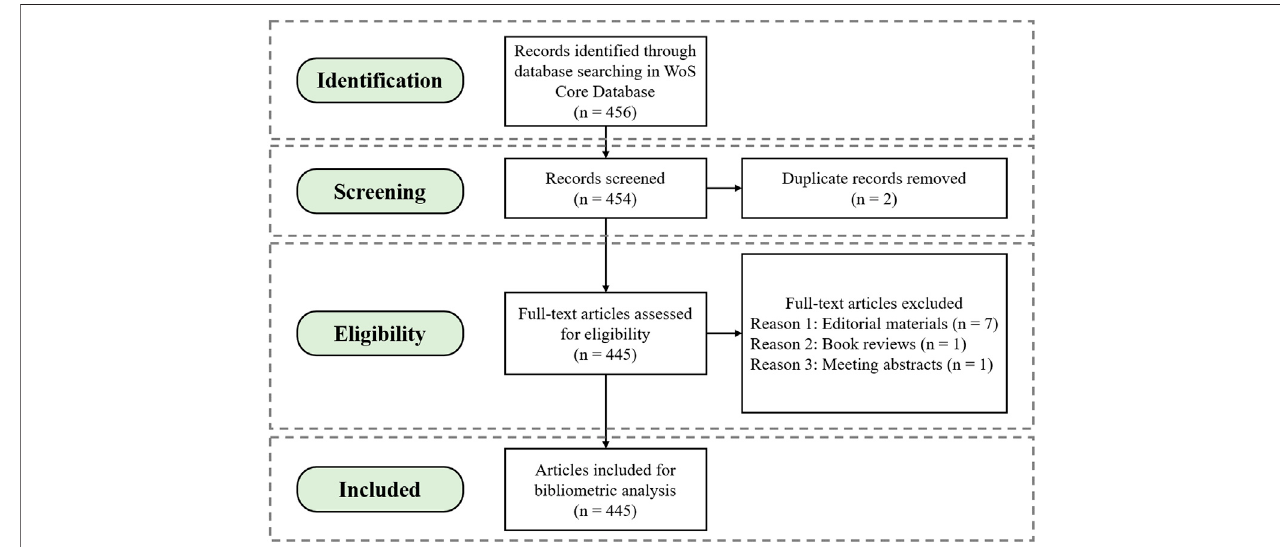
FIGURE 2 | Flowchart for conducting a literature search using the PRISMA approach.